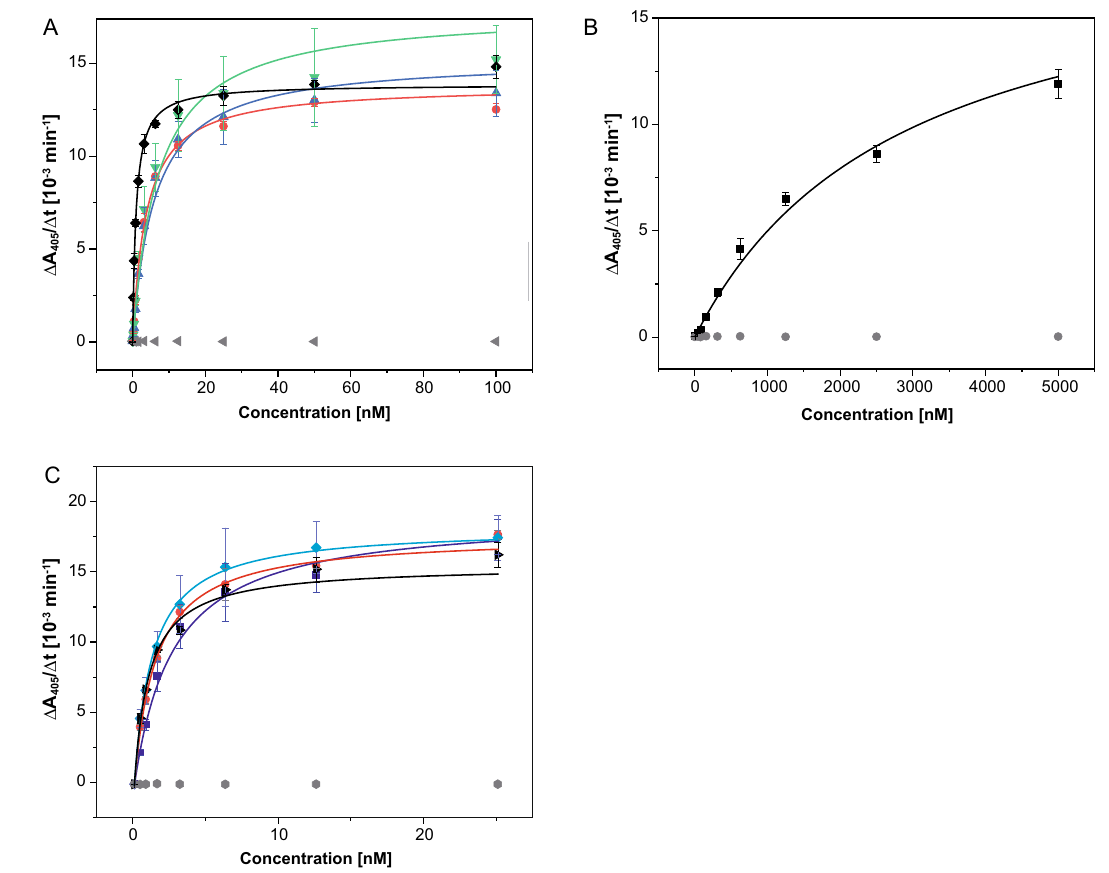
Figure 5. Investigation of the antigen-binding activity of different humanized Fab versions by ELISA. Recombinant hGal3 was immobilized on a microtiter plate, then a dilution series of the different Fabs was applied and, after washing, bound Fab was detected with a goat anti-human-kappa-light-chain-IgG alkaline phosphatase conjugate. ( A ) Chimeric αhGal3-Fab (black; K D = 1.3 ± 0.2 nM) and the initial CDR-grafted versions "4NRY" (red; K D = 3.6 ± 0.1 nM), "4KQ3" (blue; K D = 5.9 ± 1.9 nM) and "5I8C" (green; K D = 6.9 ± 1.3 nM). ( B ) The same experiment shown for the humanized Fab version "3KYM" (black; K D = 2.8 ± 0.6 µM). ( C ) Influence of single point mutations on the antigen-binding activity of the humanized Fab version "4NRY". The chimeric αhGal3-Fab (black; K D = 1.2 ± 0.1 nM), the initial CDR-grafted version "4NRY" (dark blue; K D = 2.3 ± 0.2 nM), the single point mutant "4NRY"(L4M) (red; K D = 1.5 ± 0.1 nM) and the single point mutant "4NRY"(E46K) (light blue; K D = 1.3 ± 0.1 nM). Ovalbumin (grey) served as a negative control antigen in all three experiments. Graphics were prepared using Origin(Pro) version 2017 (https:// www. origi nlab.